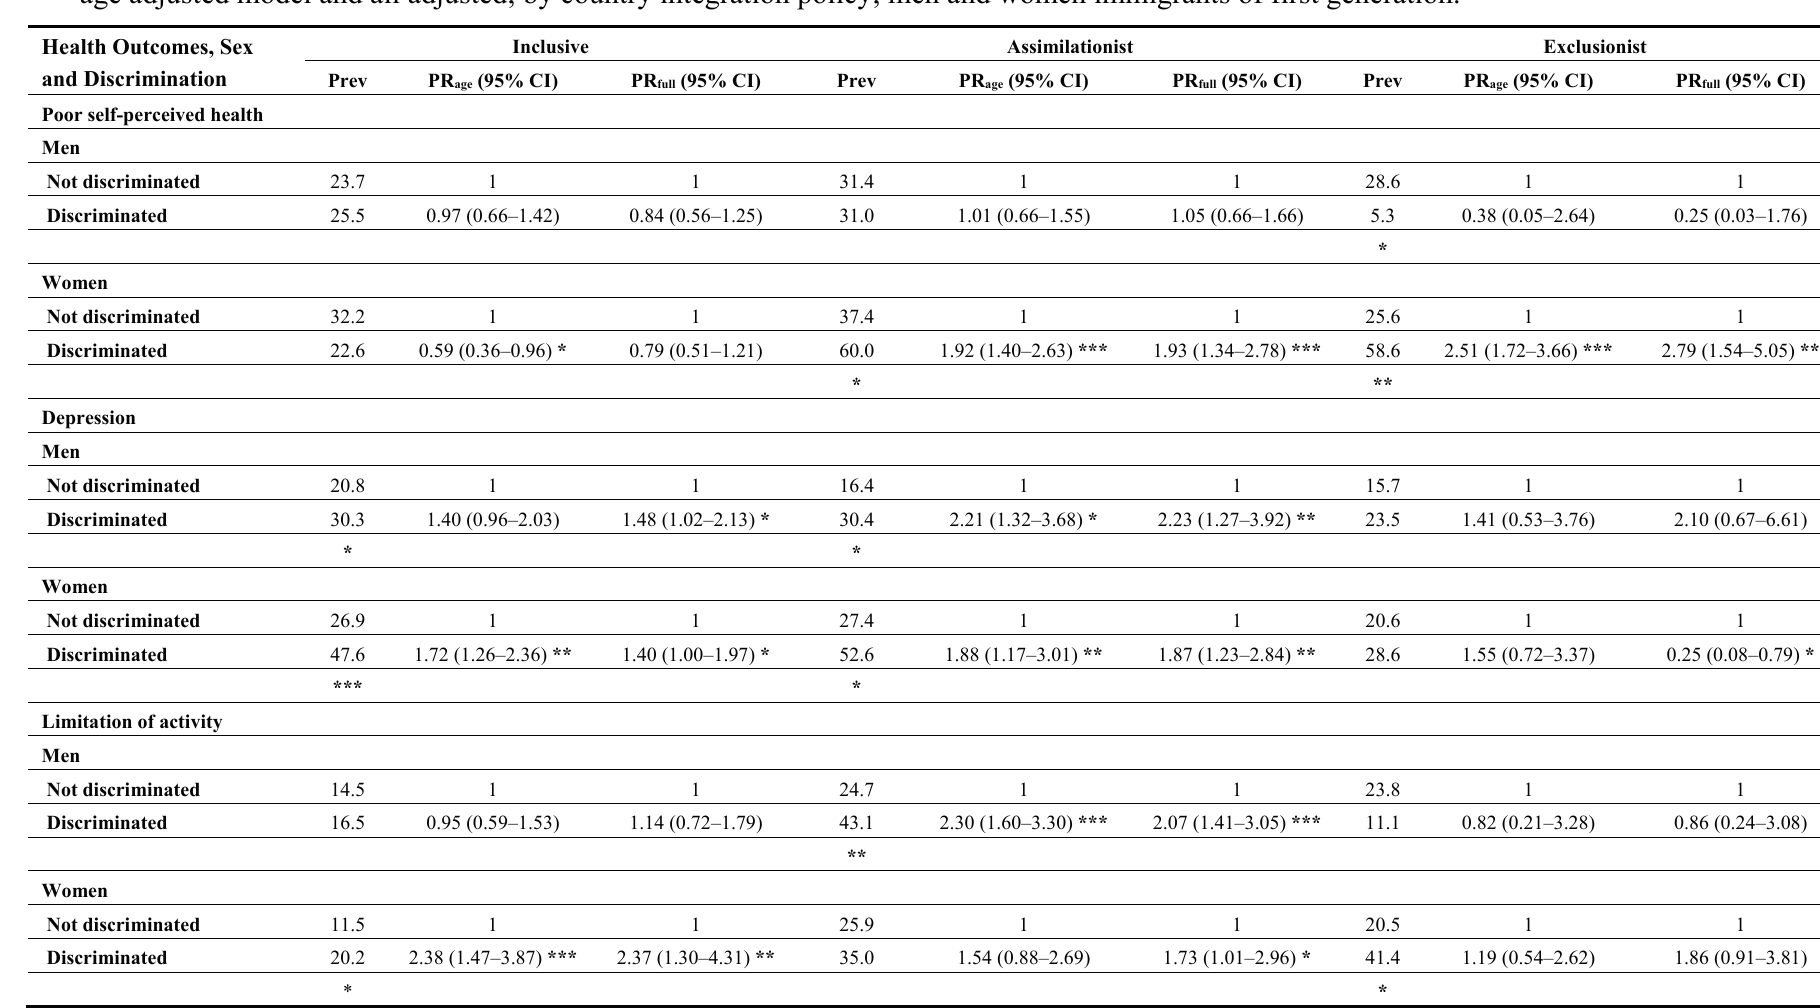
Table 3. Prevalence of health outcomes. Association of perceived group discrimination with poor health outcomes (prevalence ratios): age adjusted model and all adjusted; by country integration policy; men and women immigrants of first generation. Health Outcomes,